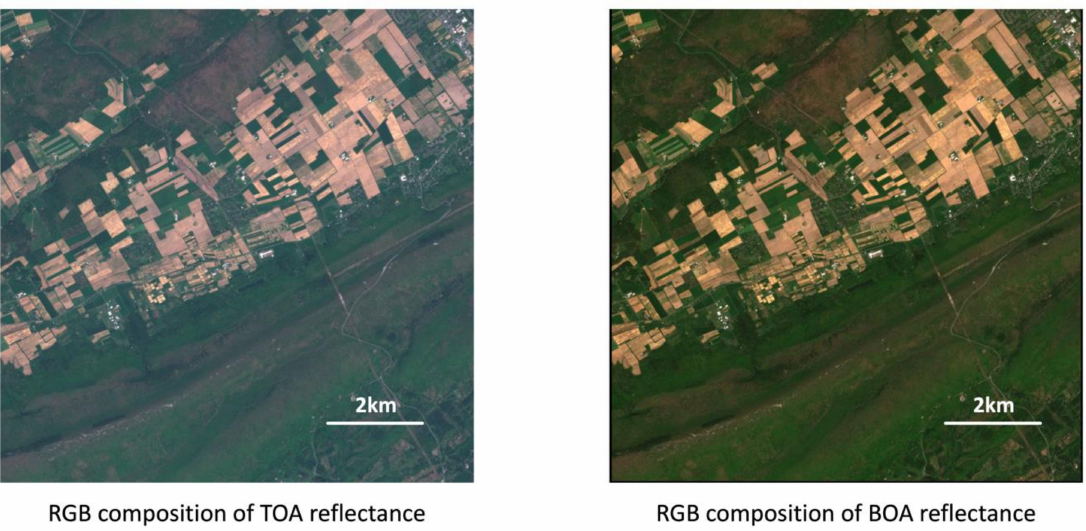
Figure 9. Example of Sentinel-2A level1 Top Of Atmosphere (TOA) reflectance (RGB composition) and BOA reflectance (RGB green-red-blue composition) derived from SIAC corrections in a 10 km * 10 km region that centres at the US-PSU site on 9 May,